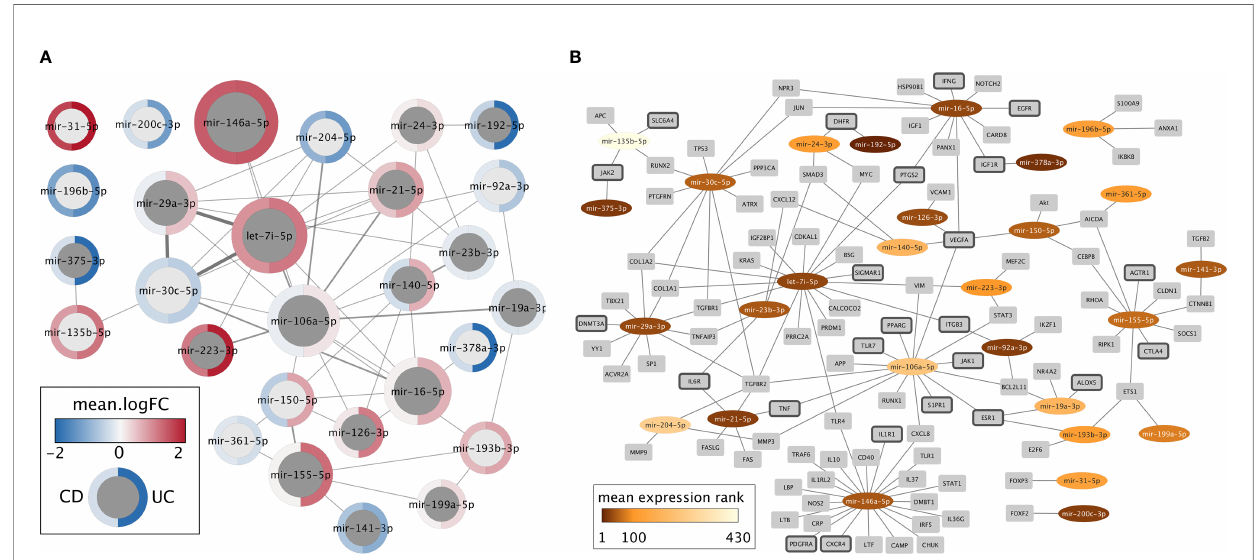
FIGURE 2 | Network representations of the 28 miRNAs with at least one experimentally determined target known to be related to IBD. (A) Network of miRNAs only. Dark gray nodes represent miRNAs detected by literature curation, while light gray nodes were not identi fi ed in the literature, but only in the meta-analysis. The size of each miRNA node corresponds to the number of IBD targets this miRNA has, and the width of the edges represents the number of shared IBD targets. The mean logFC of each miRNA, according to the meta-analysis, is shown for CD (left) and UC (right) using a blue-white-red gradient on the node border. (B) Network of miRNAs (oval nodes) and their target genes (rectangle nodes). miRNAs are colored based on their mean expression rank. Target genes that code for proteins with a clinically approved drug according to the Pharos database are highlighted by dark gray node border